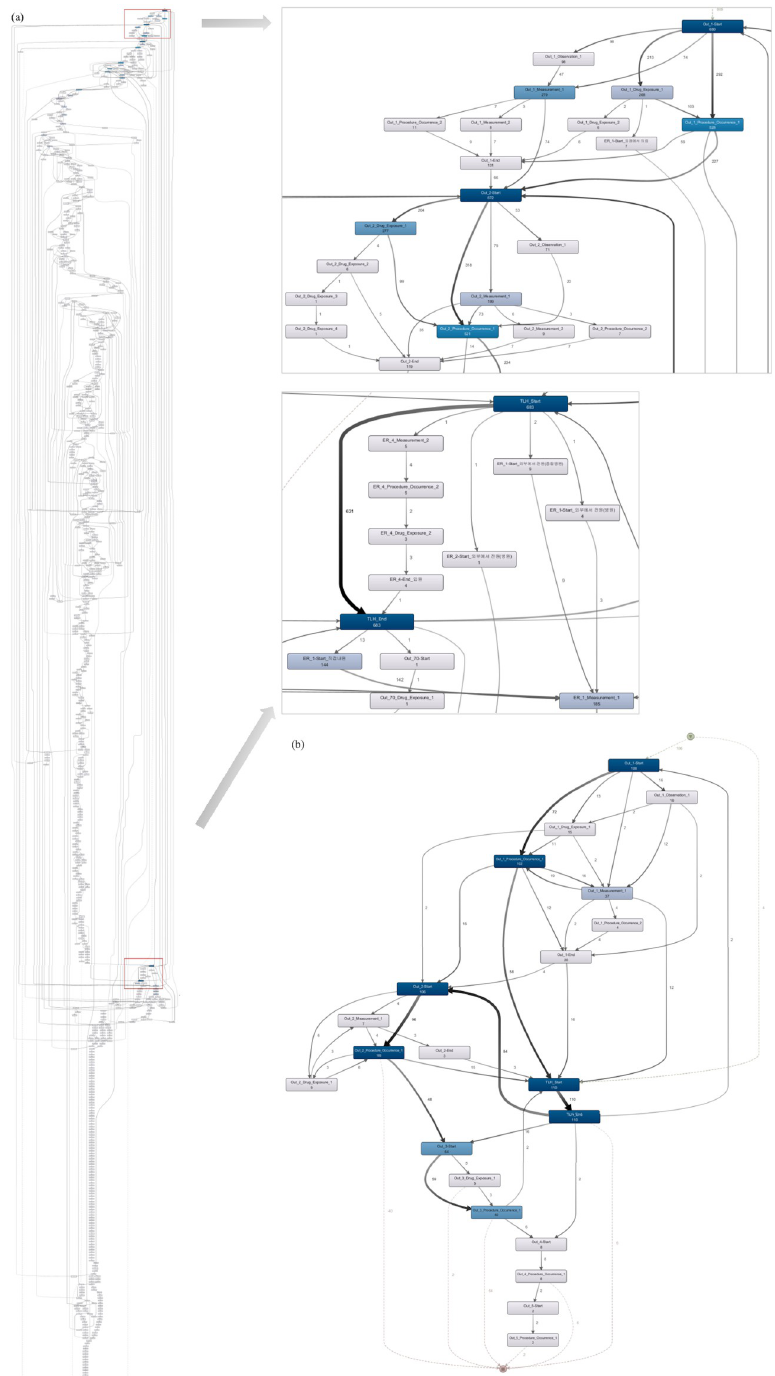
Fig 9. Patient journey map using descendent-level events. (a) process model for the entire visits (left); enlarged view of the first two outpatient visits (top right); enlarged view of the TLH inpatient visit (middle right) (b) process model with mainstream behaviors